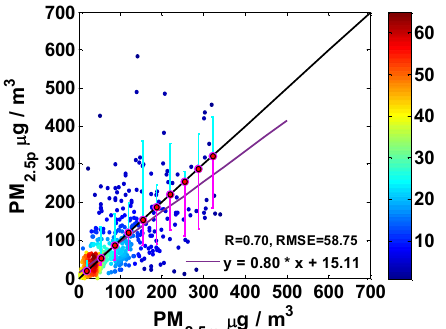
Figure 13. Validation result of the specific particle swarm extinction mass conversion algorithm (SPSEMCA) for Beijing area in 2016. The color bar from 0 to 60 represents the sample density. The blue-green error bars represent mean root mean square error (RMSE) for samples with estimated PM 2.5 larger than the measured value (samples above the 1:1 line); the magenta error bars represent the mean RMSE for samples with estimated PM 2.5 lower than the measured value (samples under the 1:1 line); the magenta points on the 1:1 line represent group centers.